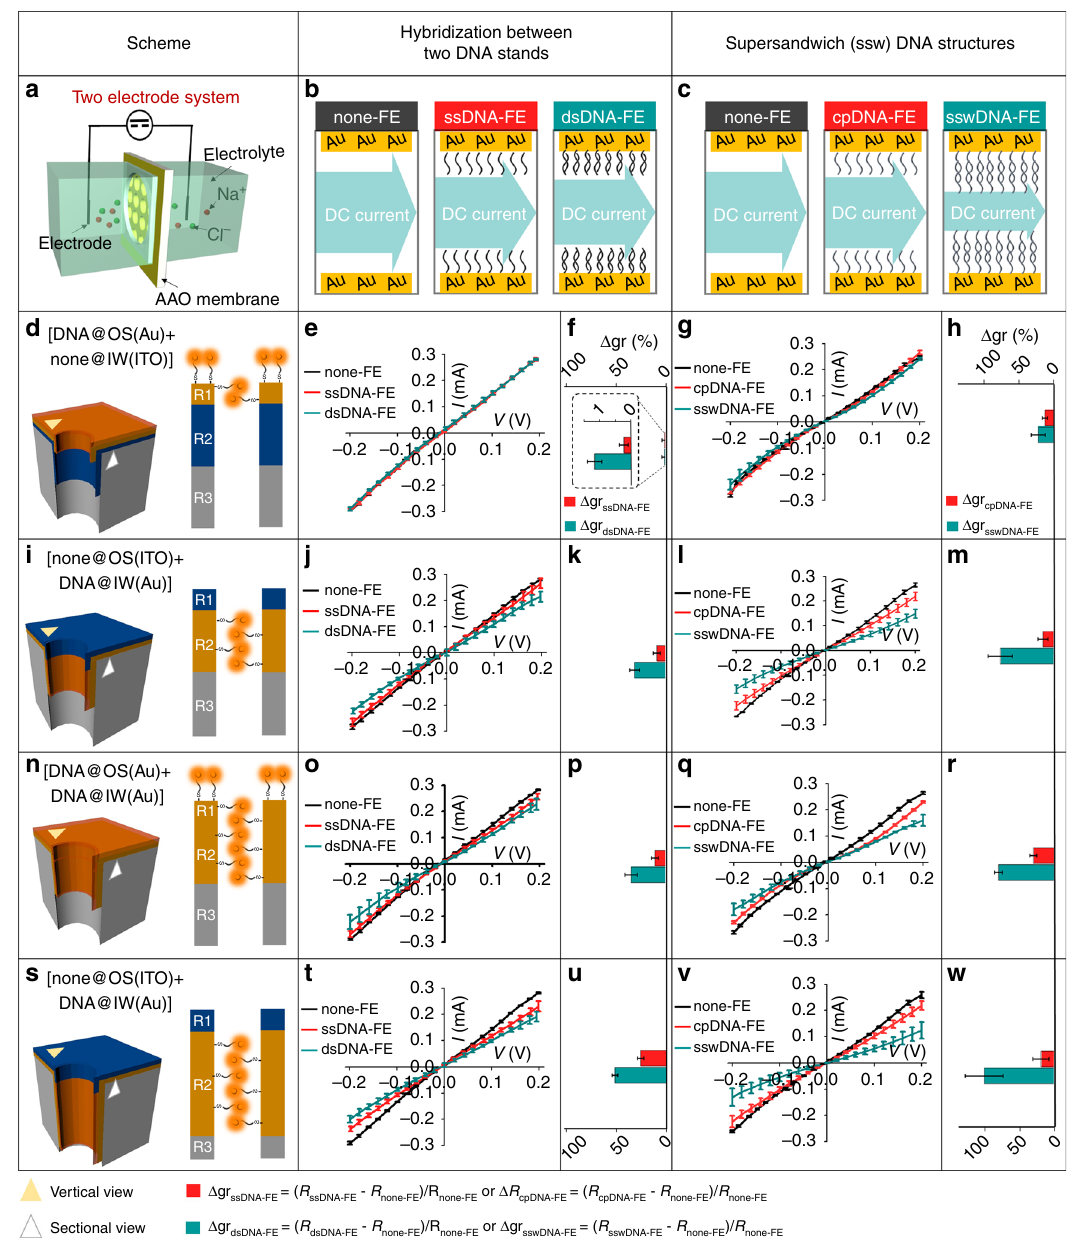
Fig. 4 Measurements of ion gating. Δ gr DNA-FE , from four kinds of samples with varied FE OS and FE IW . The I – V are applied to characterize the resistance of samples, re fl ecting the gating contribution of the IW and OS in a solid-state membrane after being modi fi ed with FE IW and FE OS on the IW and OS, respectively. a The cartoon of two-electrode system is used in electrochemical characterizations. Ions go through the nanochannels under the direct current (DC). There are several states of FE OS and FE IW at Au surface: b none-FE, ssDNA-FE grafting and dsDNA-FE grafting. c none-FE, cpDNA-FE grafting and sswDNA-FE grafting. Schemes illustrate the distribution of FE OS and FE IW at OS and IW, in four samples which are described in ( d , i , n , s , respectively. I – V curves characterize the current of the state as: none-FE grafting, ssDNA-FE grafting and dsDNA-FE grafting in four samples which are described in e , j , o , t ; none-FE grafting, cpDNA-FE grafting and sswDNA-FE grafting in four samples which are described in g , l , q , v . Varied Δ gr are de fi ned in the bottom part. Calculated Δ gr are shown in f , k , p , u for DNA hybridization and h , m , r , w for sswDNA formation. Error bars represent standard deviations of the measured samples. Five experimental replicates for each